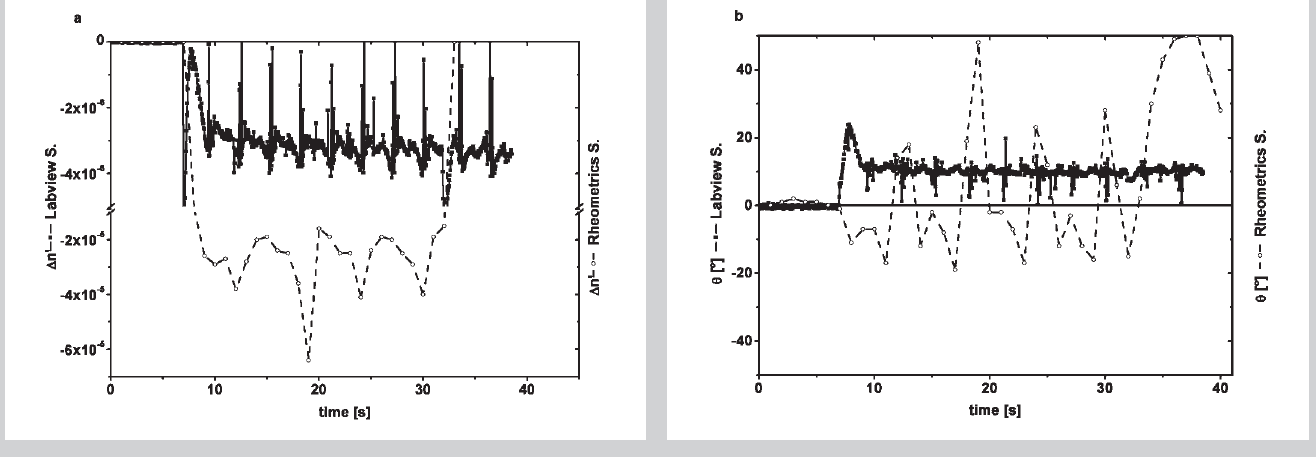
Figure 5: Comparing birefringence data as measured with the commercial Rheometrics Software (lines with empty circles) and using the home- built Labview software (lines with filled squares) see Figure 5a. The sample is PS in DOP at 20°C with shear rate of 20 s -1 . The back- ground compensation (see text) was used for all the measurements irrespective of home written or com- mercial software. The home written Labview software acquires more data per time and the values of the bire- fringence correspond well to earlier measurements [18] in contrary to the commercial software. It is furthermore possible to detect the over- shoot during the onset of shear. Comparison of the orientation angle q , data measured with the commer- cial Rheometrics software (lines with open circles) and with the home written Lab- view program (lines with filled squares) see Figure 5b. The Labview software acquires more data per time and the values of the orien- tation angle have the cor- rect sign. It is further possi- ble to detect the overshoot during the onset of